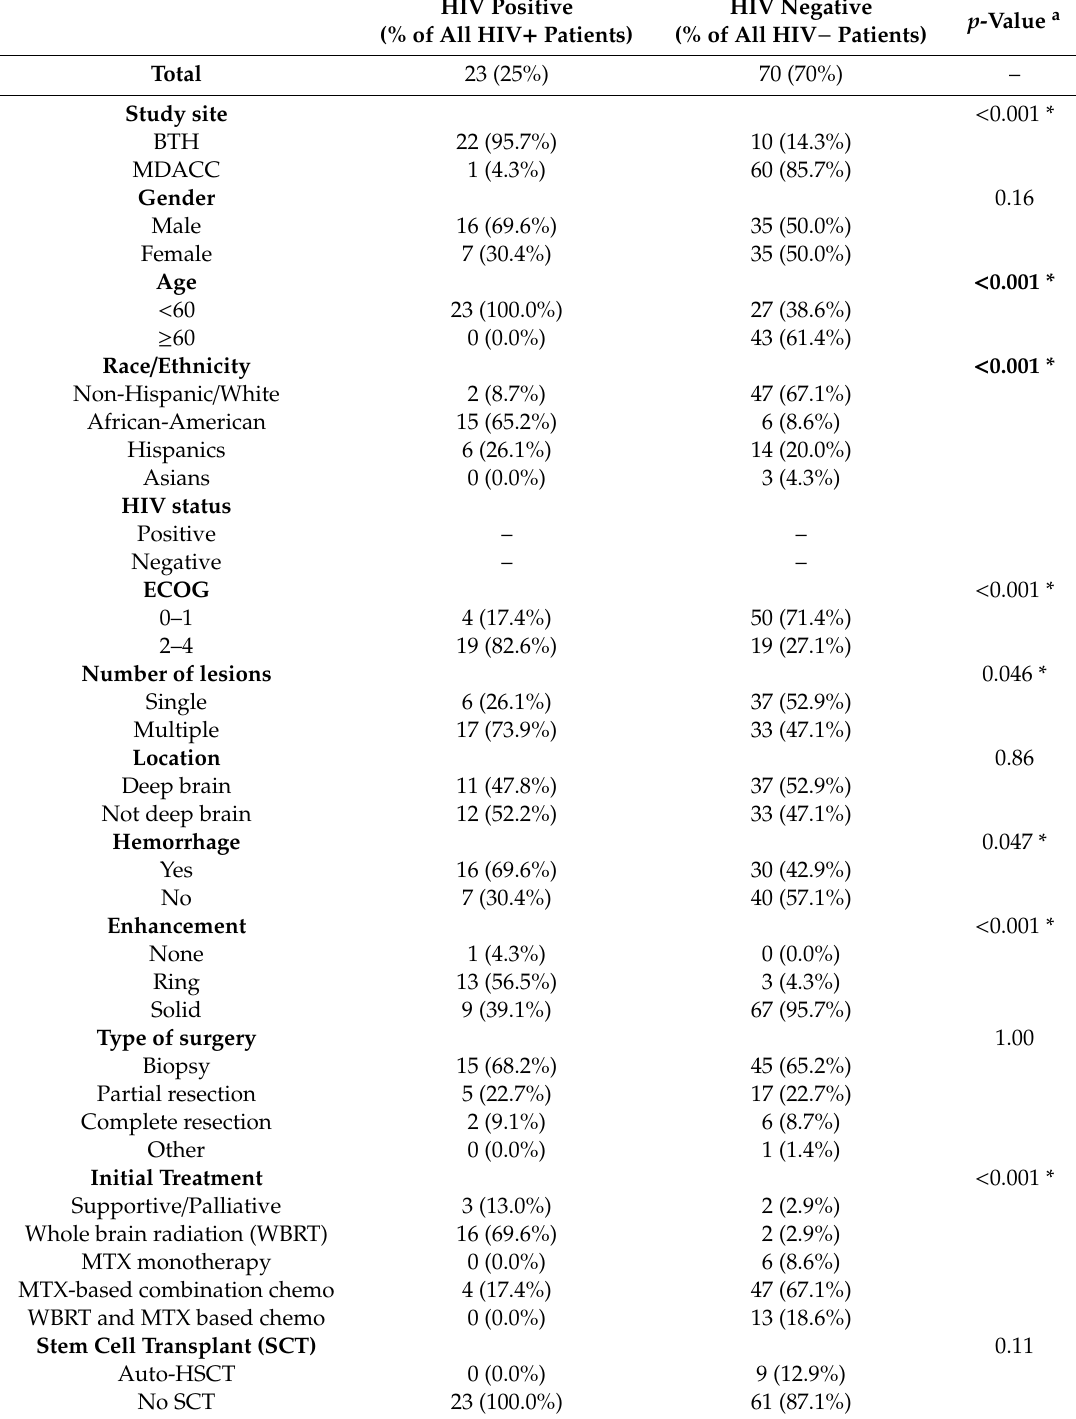
Table 2. Patient information and qualitative imaging characteristics comparing HIV-positive with HIV-negative patients. Results considered significant (*) when p <